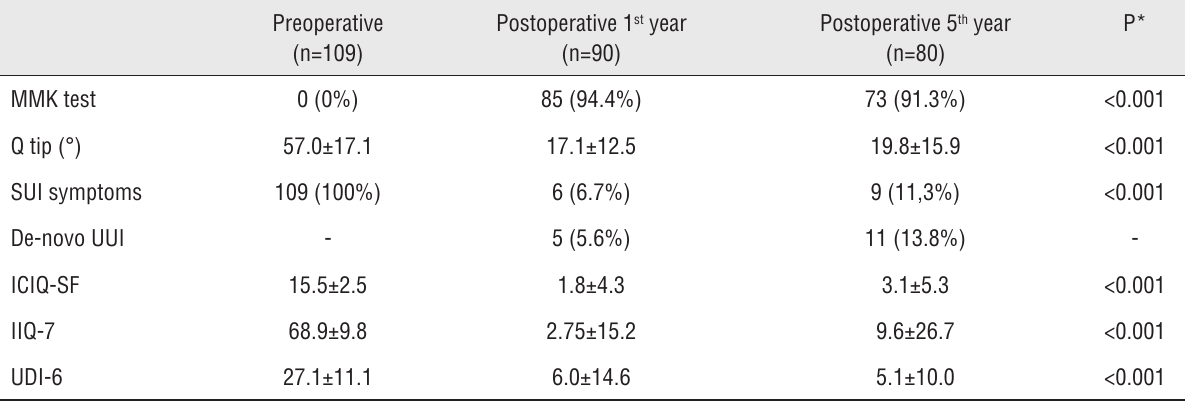
Table 2 - The comparison of the questionnaires scores, UI symptoms and physical examination results of patients according the follow - up years (preoperative vs postoperative 1 st year and preoperative vs postoperative 5 th